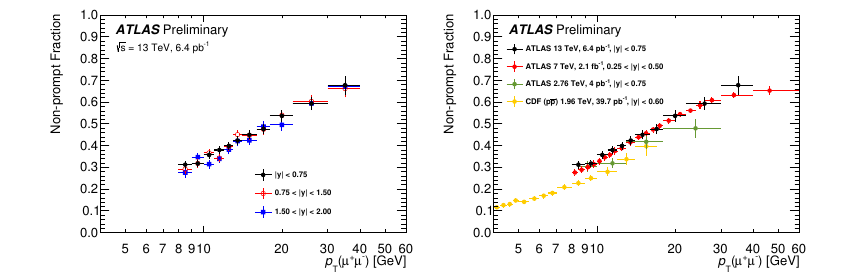
Figure 2. (Left) non-prompt J /ψ production fraction as a function of p T and in three intervals of rapidity and (right) comparison of the measurement in the most central rapidity region | y | < 0 . 75 to previous measurements by ATLAS and CDF at smaller energies. Figures are taken from Ref.